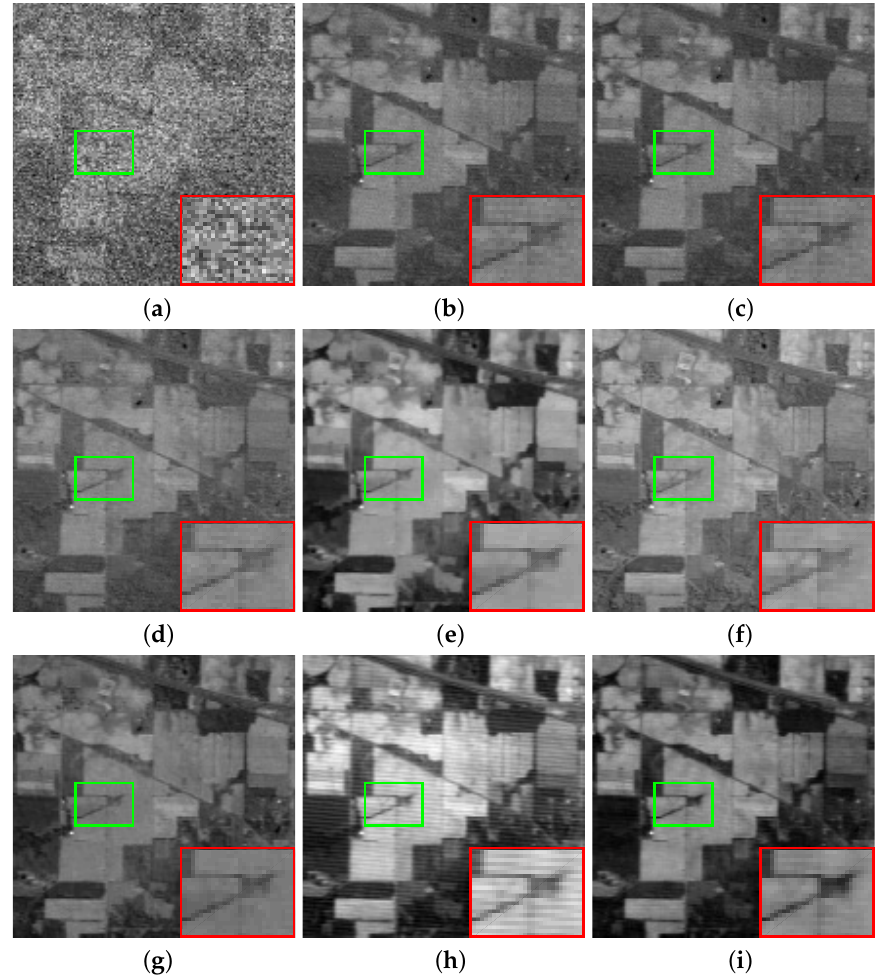
Figure 15. ( a ) Original image, image denoised by ( b ) LRTA, ( c ) BM4D, ( d ) LRMR, ( e ) LRTDTV, ( f ) L1HyMixDe, ( g ) LRTDGS, ( h ) 3DTNN, ( i ) ours of band 163 in